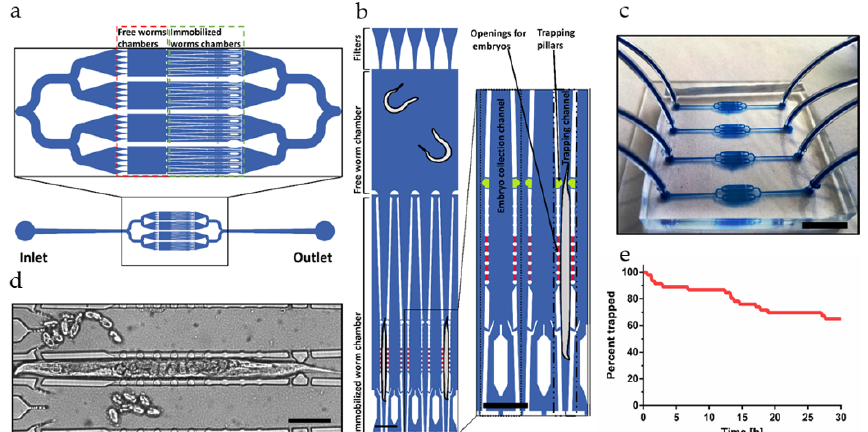
Figure 1. Microfluidic device for C. elegans immobilization and intestinal bacterial load imaging. ( a ) Schematic representation of an on-chip assay unit with 4 large channels each comprising a free-worm chamber (850 μ m × 1200 μ m, 60 μ m high) and a section with 4 worm traps. ( b ) Schematic view of one of the channels. Passive PDMS filter structures (upper part of the figure) are located in front of each free-worm chamber to allow selective loading of YA worms. Smaller tapered channels guide the worms into the traps. Each trap has 2 opposite passive PDMS pillar structures for secured worm confinement (highlighted in green). Evacuation of embryos is possible through an arrangement of openings (20 μ m × 25 μ m, 40 μ m high, highlighted in red) in the sidewalls of the traps. Feeding of immobilized worms independently from the body orientation is enabled by 2 lateral openings close to the end of the trap (see enlarged schematic view) and lateral openings at the location of the 2 trapping pillar structures (green). Scale bar = 200 μ m. ( c ) Photograph of the PDMS chip